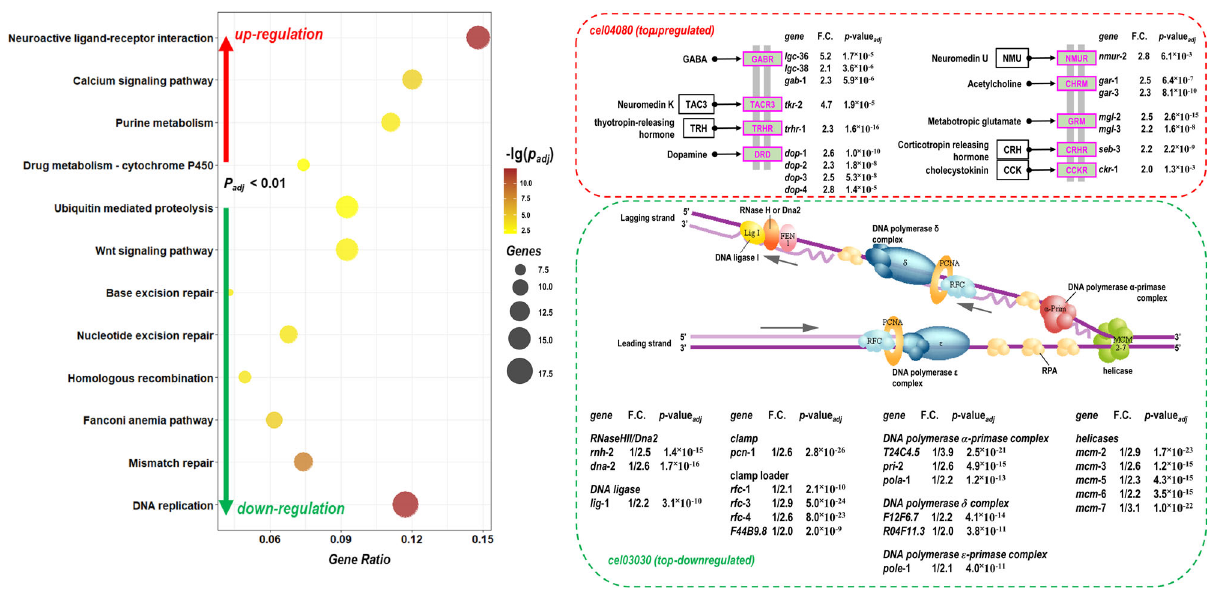
Fig. 7 The KEGG pathway enrichment analysis of the differential transcriptomes for PT-fed Caenorhabditis elegans , using the S + /D4 vs S-/ D4 sample. a The dotplot of enriched KEGG pathways with p adj < 0.01, b the up-regulated gene expressions in the top-ranked neuroactive ligand-receptor interaction pathway (cel04080), c the down-regulated gene expressions in the top-ranked DNA replication pathway